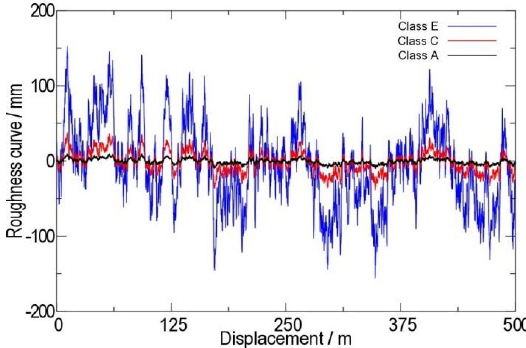
Figure 1. Road roughness curves of Class A, C, and E.